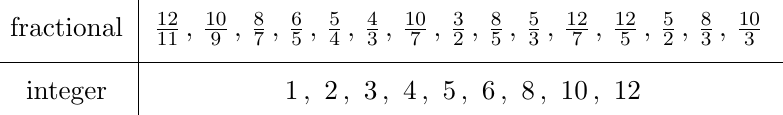
Table 2. List of the allowed values of scaling dimensions of Coulomb branch operators for rank-2 N = 2 SCFTs. This list relies on the assumption that the Coulomb branch chiral ring is freely